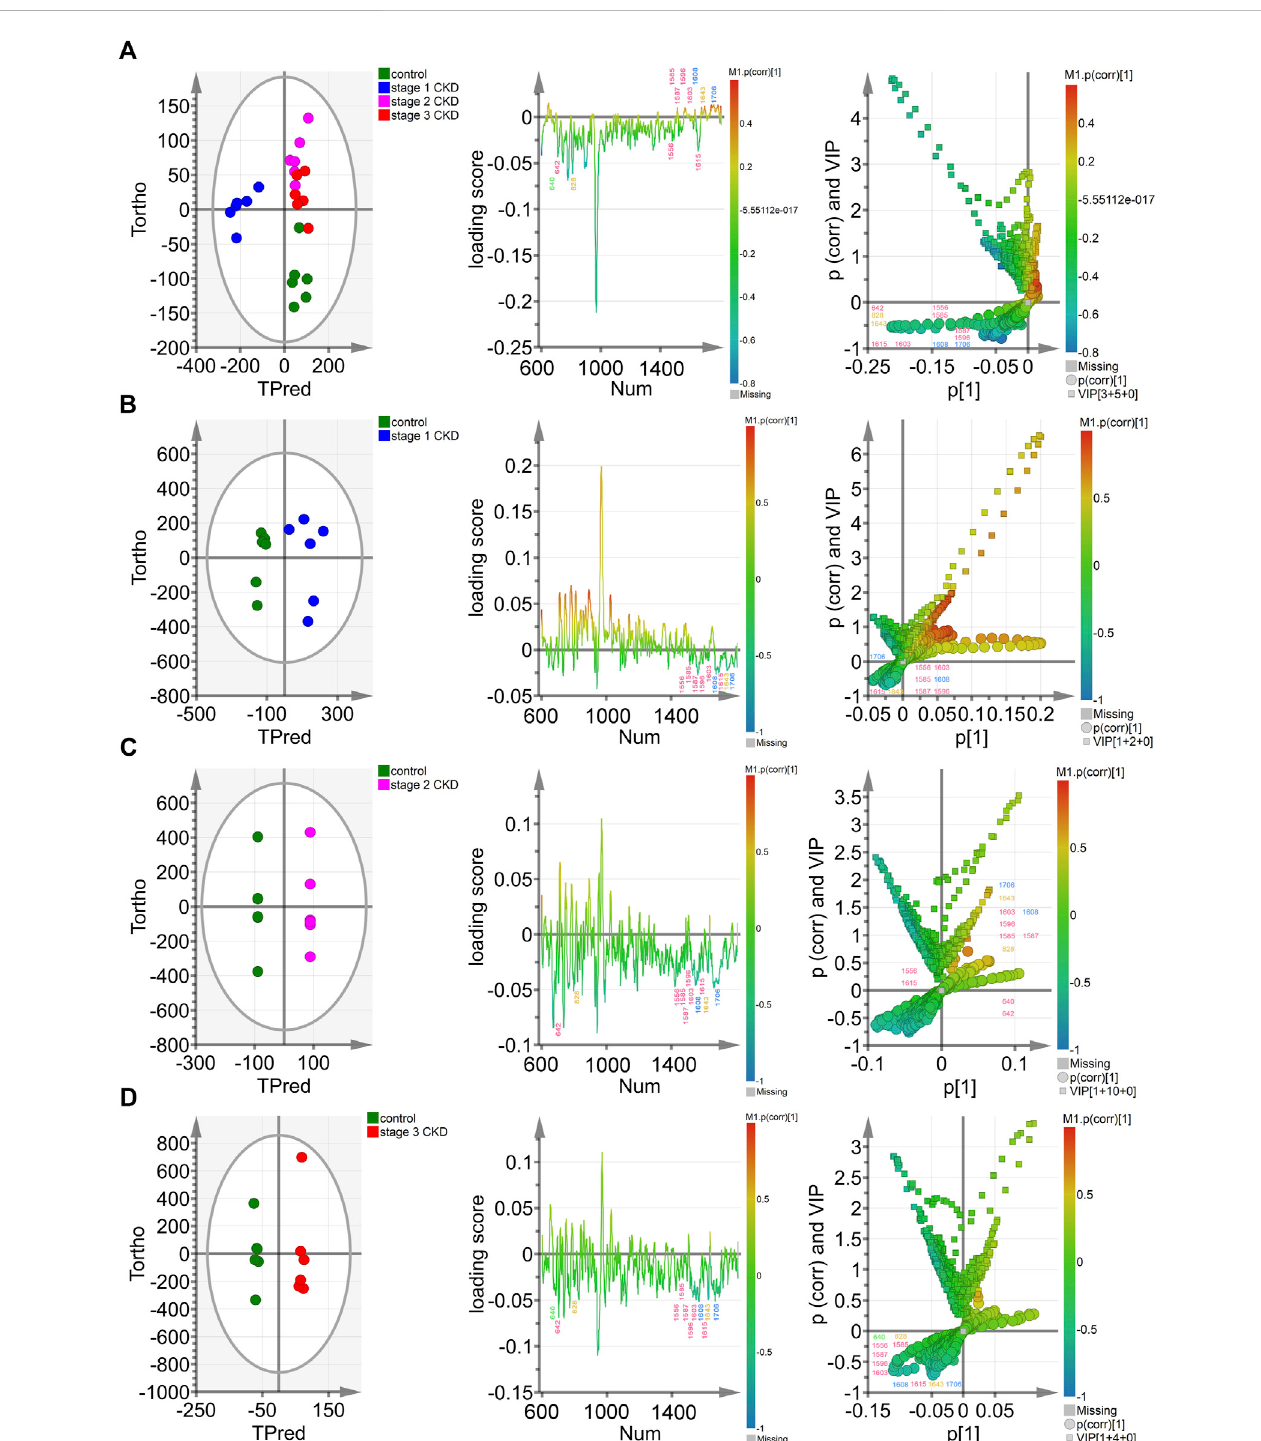
FIGURE 3 MultivariateanalysisofcontrolgroupsanddifferentCKDstageswithhyperuricemia (A) TheOPLS-DAmodelwasconstructedbetweenthecontrolgroup andthethreeCKDoneatdifferentstages,andtheHotelling ’ sT2ellipsescoremap,loadmap,andV+Smapofthe95%con fi dencezoneweredrawn; (B) .The OPLS-DAmodelwasconstructedbetweenthecontrolgroupandstage1CKDgroup,beforedrawingtheHotelling ’ sT2ellipsescoremap,loadmap,andV+S map of the 95% con fi dence zone; (C) . The OPLS-DA model was constructed in the control group and phase two CKD group, with the Hotelling ’ s T2 ellipse score map, load map and V + S map of the 95% con fi dence zone subsequently drawn; (D) . The OPLS-DA model was constructed between the control group and the stage 3 CKD group before drawing the Hotelling ’ s T2 ellipse score map, load map and V + S map of the 95% con fi dence